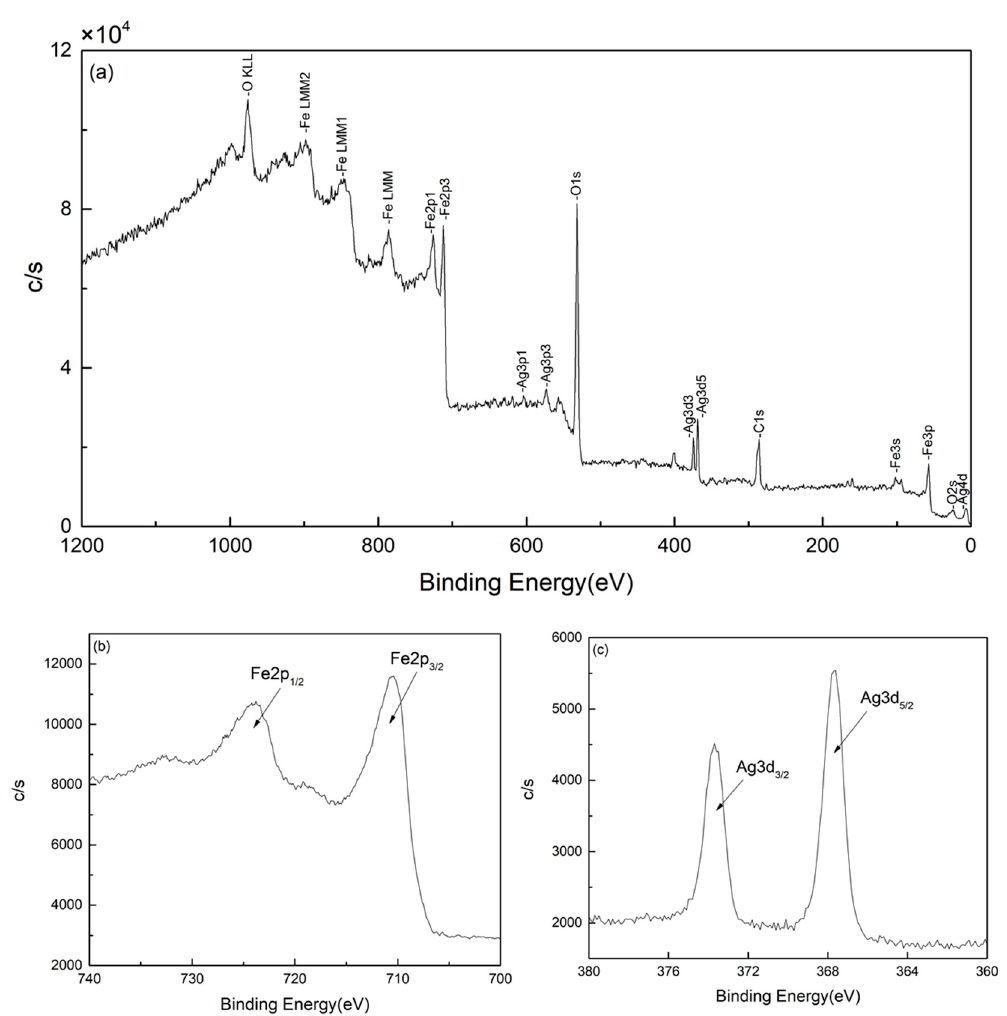
Figure 4. XPS spectra of ( a ) Fe 3 O 4 @Ag particles ( b ) Fe 2p peaks of Fe 3 O 4 @Ag particles and ( c ) Ag 3d peaks of Fe 3 O 4 @Ag particles.